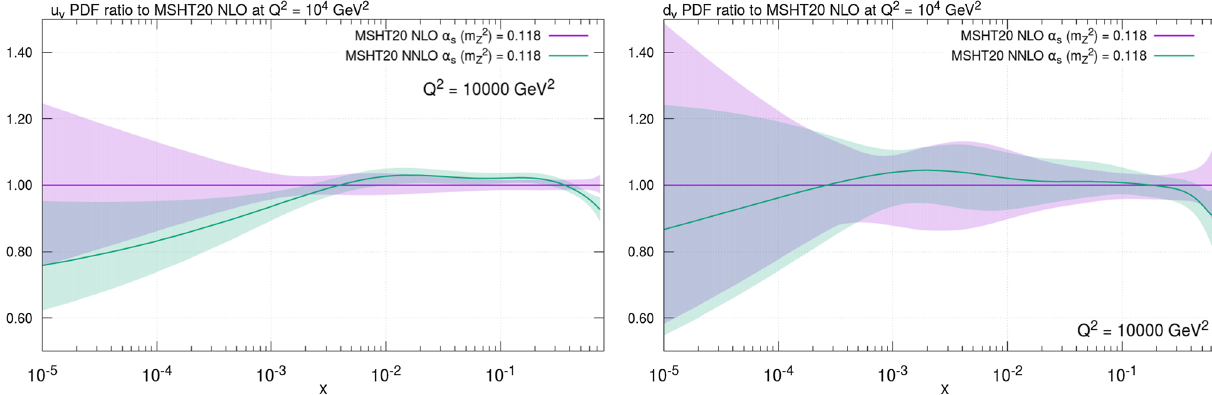
Fig. 39 (Left) u V and (right) d V PDFs showing the ratio of the MSHT20 PDFs to their NLO values, at Q 2 = 10 4 GeV 2